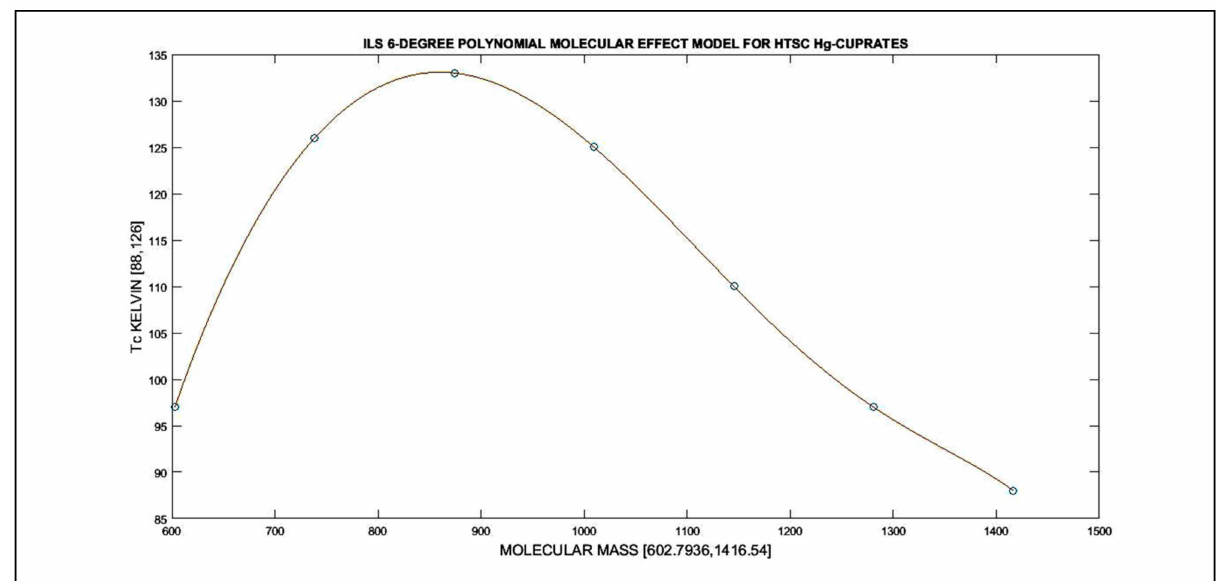
Figure 8. Molecular effect model with ILS 6-degree polynomial fit. Generally, Tc matches a parabolic curve when the molecular weight increases.